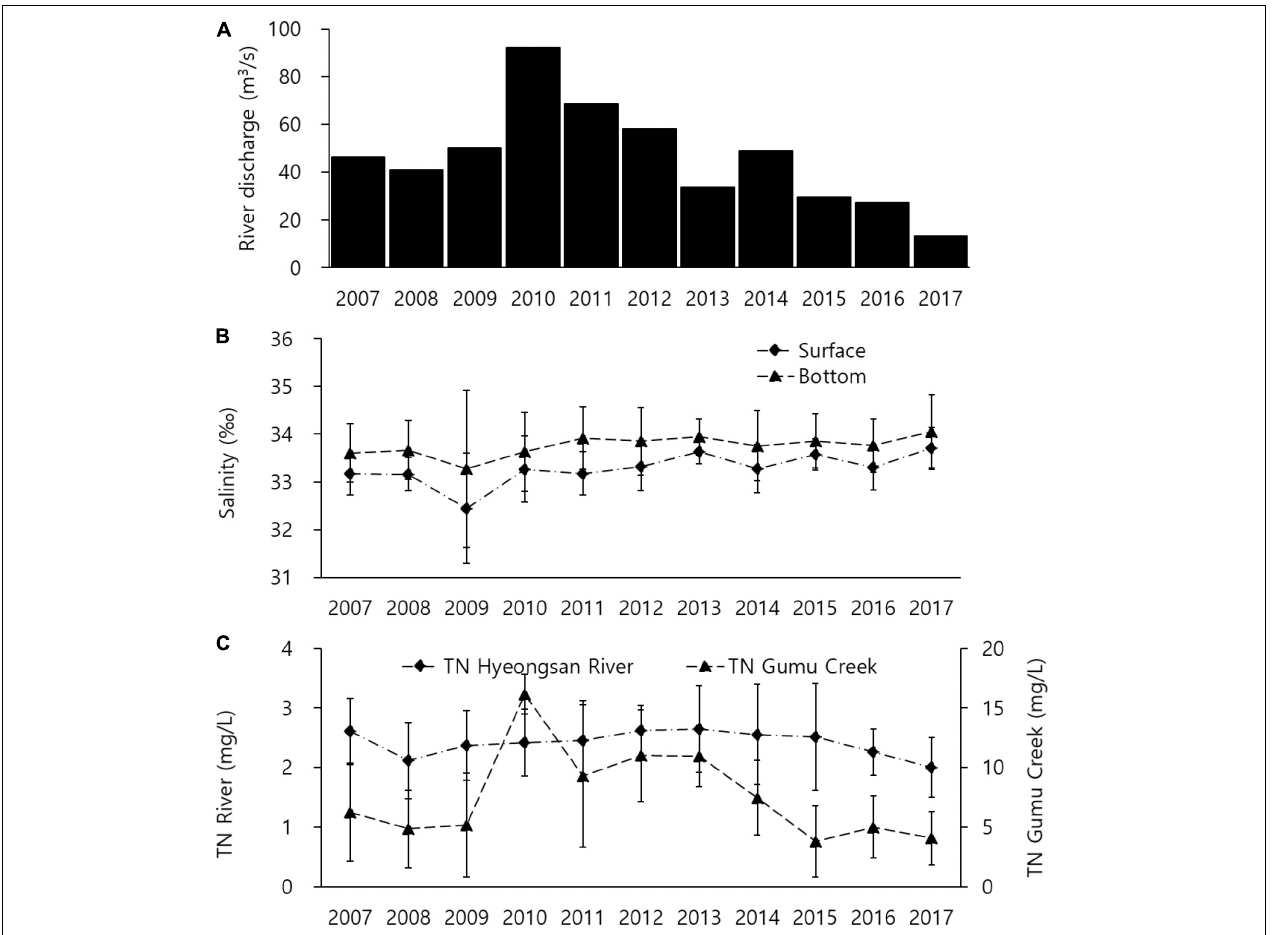
FIGURE 2 | Long-term variation in river discharge (A) , salinity (B) , and total nitrogen (TN) from the Hyeongsan River (HR) and Gumu Creek (C) , where the Pohang Iron and Steel Company (POSCO) is located. This company is mainly responsible for the TN discharge from the Gumu